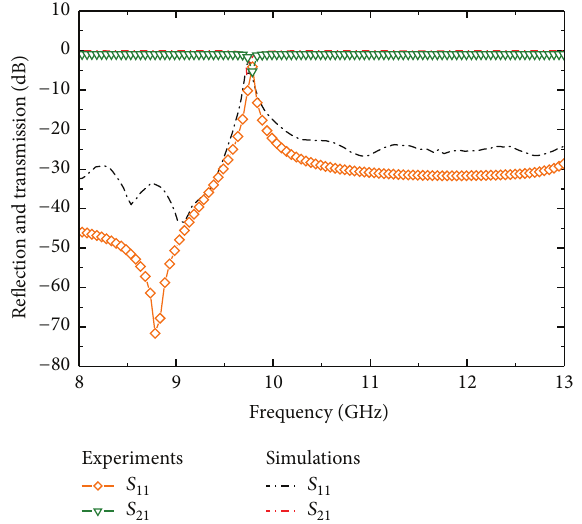
Figure 7: CaTiO 3 cube by 2 × 2 × 2mm was tested in waveguide with the magnitude of S parameter: S 21 of transmission and S 11 of reflection,includingthecomparisonofsimulationsandexperiments on S 11 and S 21